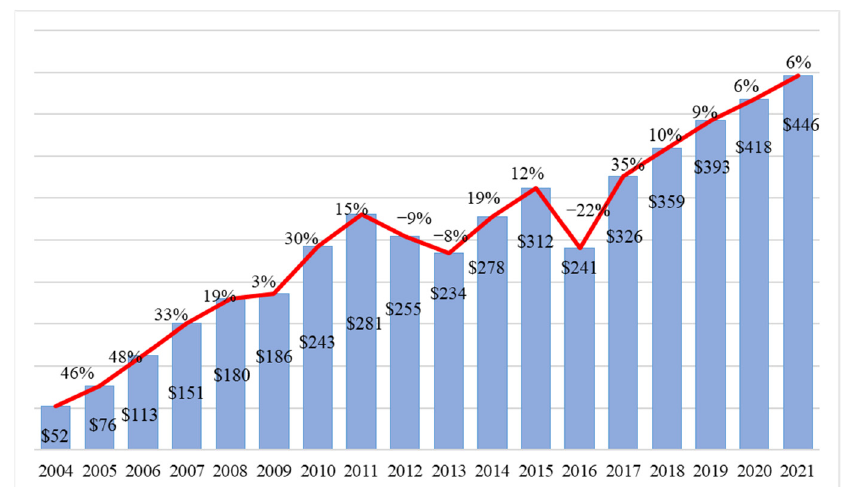
Figure 2. Global investment in clean energy, 1990–2021 (in USD billions).